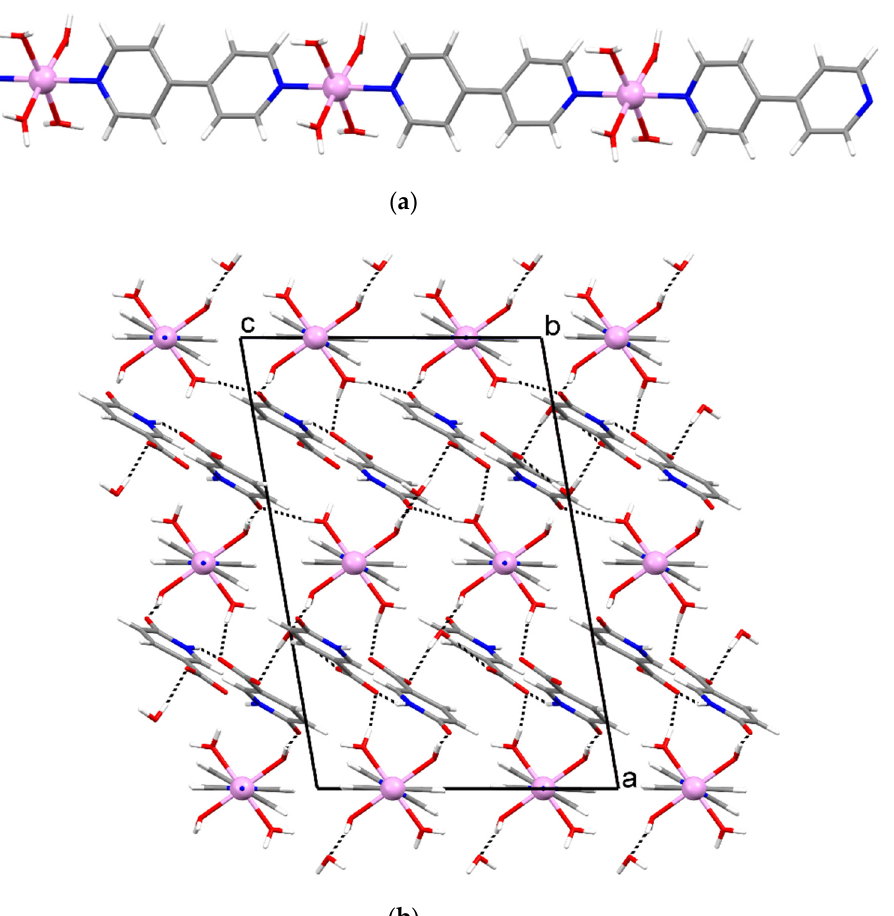
Figure 2. The infinite one-dimensional polymeric chain of {[Co(4,4 ′ -bpy)(H 2 O) 4 ] 2+ } n cation in 1 , extending along the [0 1 0] direction ( a ). A fragment of the infinite hydrogen-bonded framework of {[Co(4,4 ′ -bpy)(H 2 O) 4 ](6-Onic) 2 ·2H 2 O} n ( 1 ), viewed down the [0 1 0] direction ( b ), with the {[Co(4,4 ′ - bpy)(H 2 O) 4 ] 2+ } n cations (represented as monomeric molecules in this projection), 6-oxonicotinate anions and lattice water molecules being connected via strong intermolecular O–H ··· O and N–H ··· O hydrogen bonds (represented by the dotted lines).